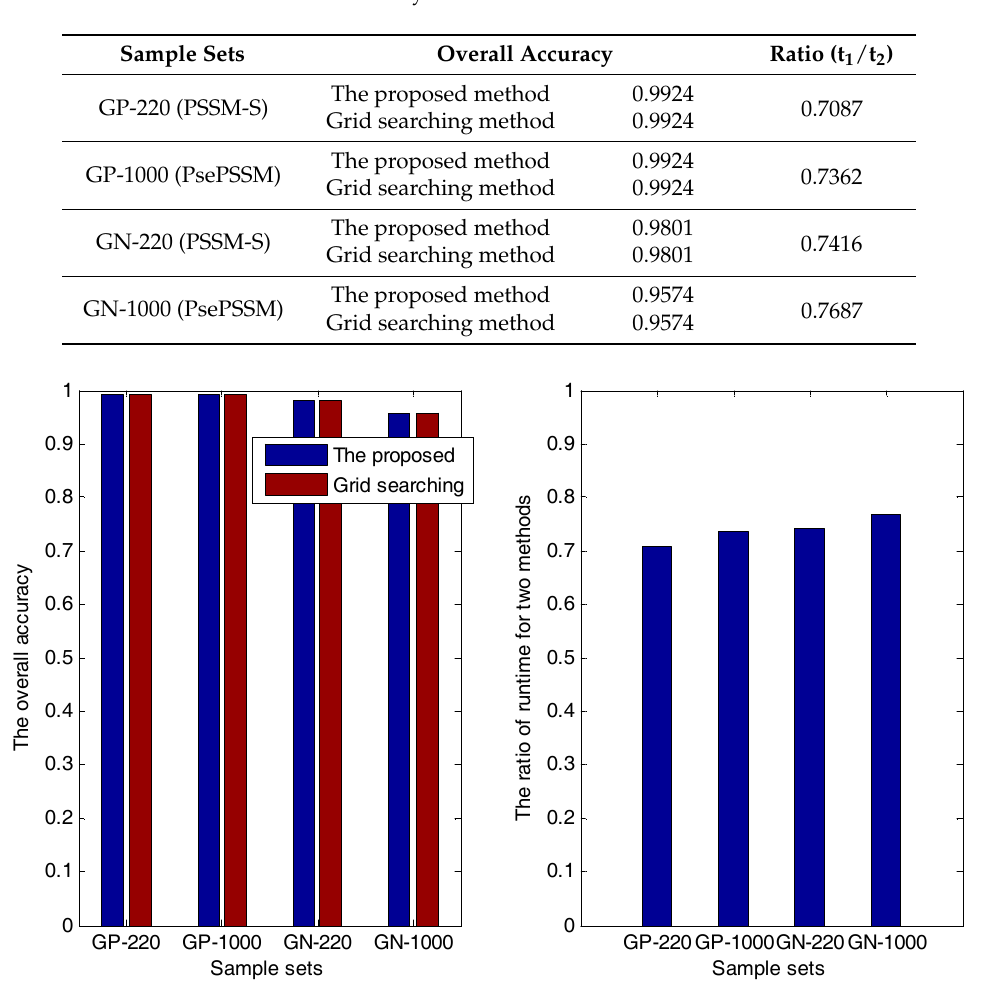
Table 1. The overall accuracy and the ratio of runtime for two methods.